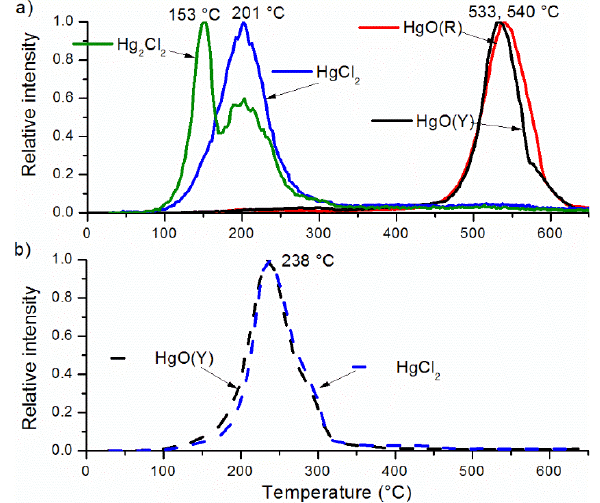
Cl , HgCl , HgO(Y) and HgO(R) mixed 2 2 2 and HgO(Y) in precipitates 2